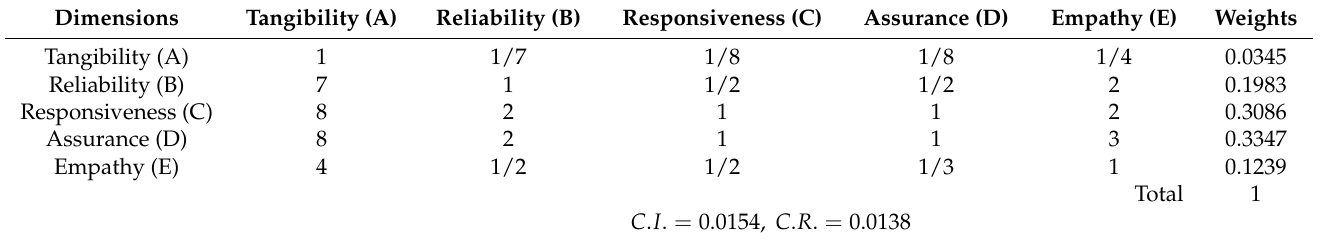
Table 9. The pairwise comparison matrix of five dimensions from FANP model.